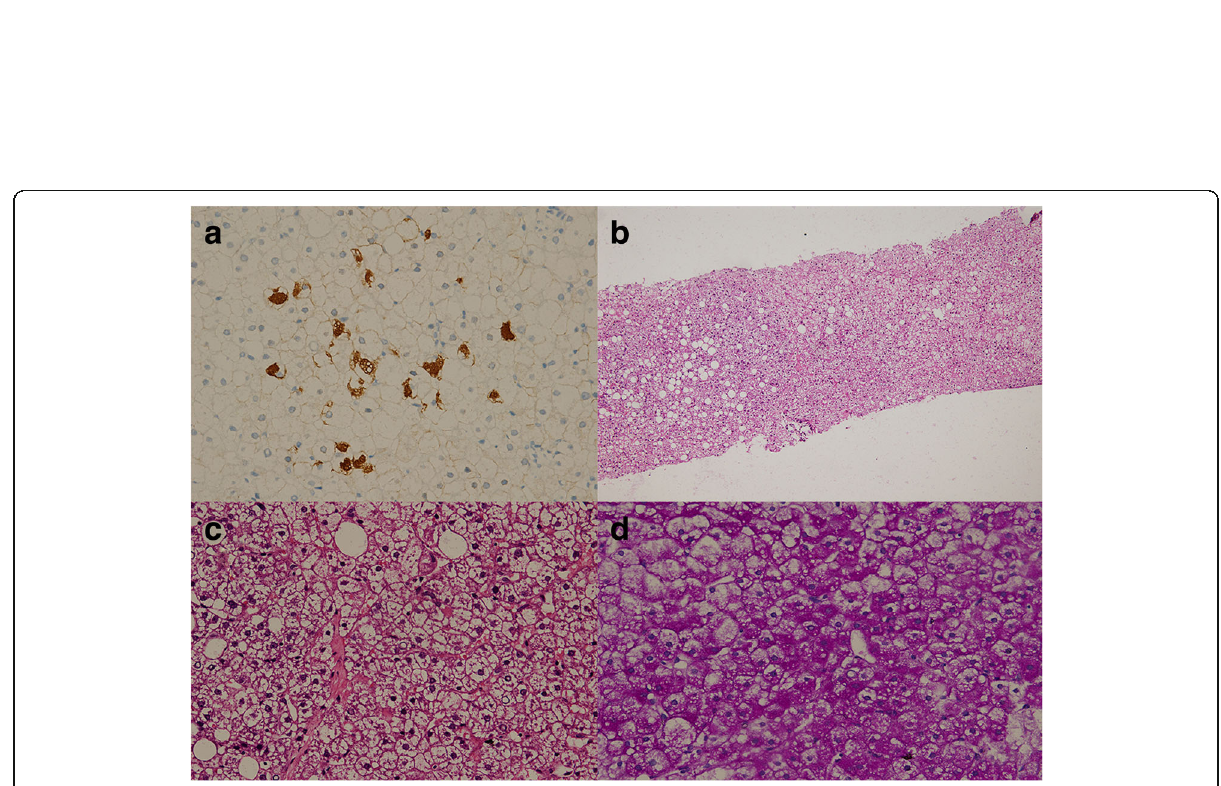
Fig. 2 Pathological examination. a HBsAg staining of several cells was positive (400×). b HE staining of liver biopsy tissue (100×). c HE staining of liver biopsy tissue (400×). d PAS staining suggested a large deposition of glycogen in